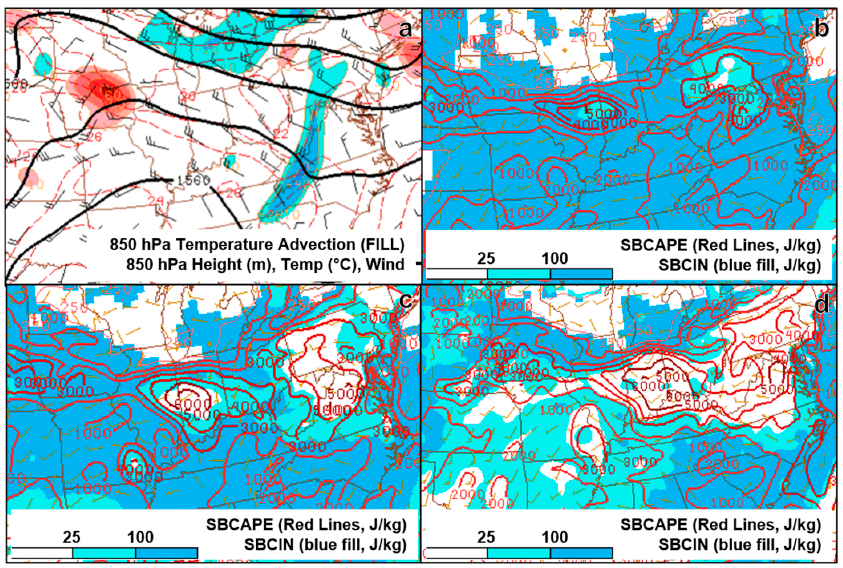
Figure 9. Panel ( a ) shows 850 hPa SPC experimental RAP analyses of temperature advection ( ◦ C/hour, blue and red fill), heights (m, black lines), temperature ( ◦ C, red dashed lines), and wind (black barbs) at 1400 UTC 29 June. Panels b, c, and d show surface-based (SB) CAPE (J kg − 1 , red lines) and CIN (J kg − 1 , blue fill) at ( b ) 1400 UTC, ( c ) 1600 UTC, and ( d ) 1800 UTC 29 June